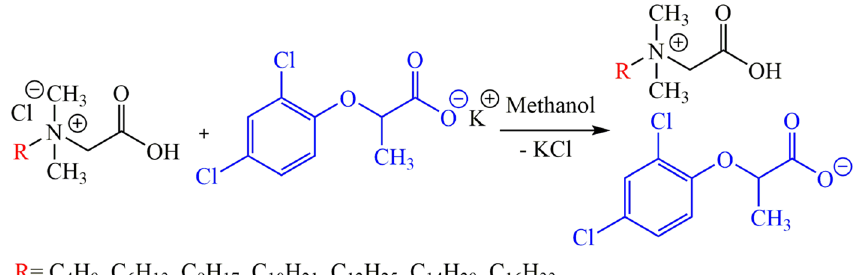
Table 2. Synthesized alkyldimethylglycinium 2-(2,4-dichlorophenoxy)propionates ( 8 – 14 ).